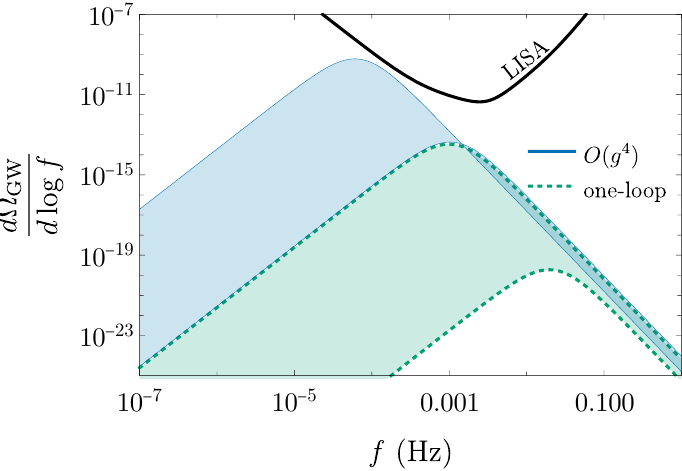
Figure 7. Similar to figure 1, for BM2. Note that in both approximations the bubble nucleation rate is only accurate to O ( ~ 0 ) within the 3d EFT. The corresponding LISA signal-to-noise ratios for a 3 year mission profile [3] vary from 0.16 to 12 in the O ( g 4 ) approximation, and from 1 . 5 × 10 − 9 to 0.12 in the one-loop